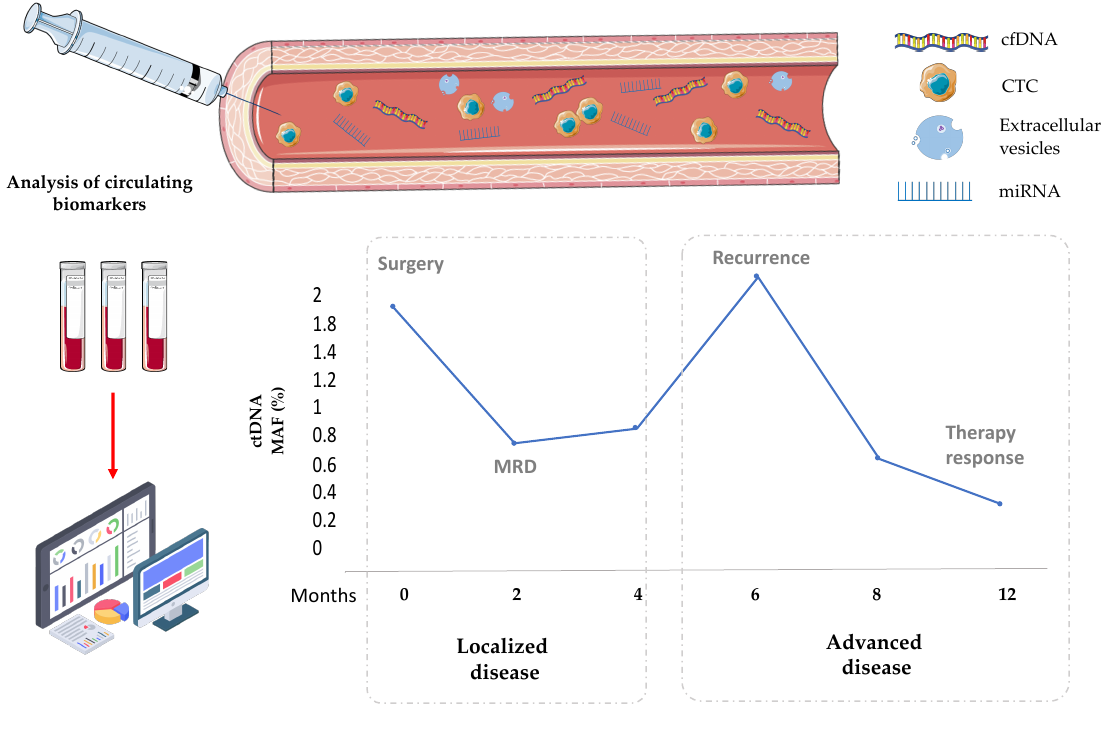
Figure 1. Clinical contexts for the application of liquid biopsy (CTCs, cfDNA, cEVs and miRNAs) to improve the management of patients with both localized and advanced EC. MRD, minimal